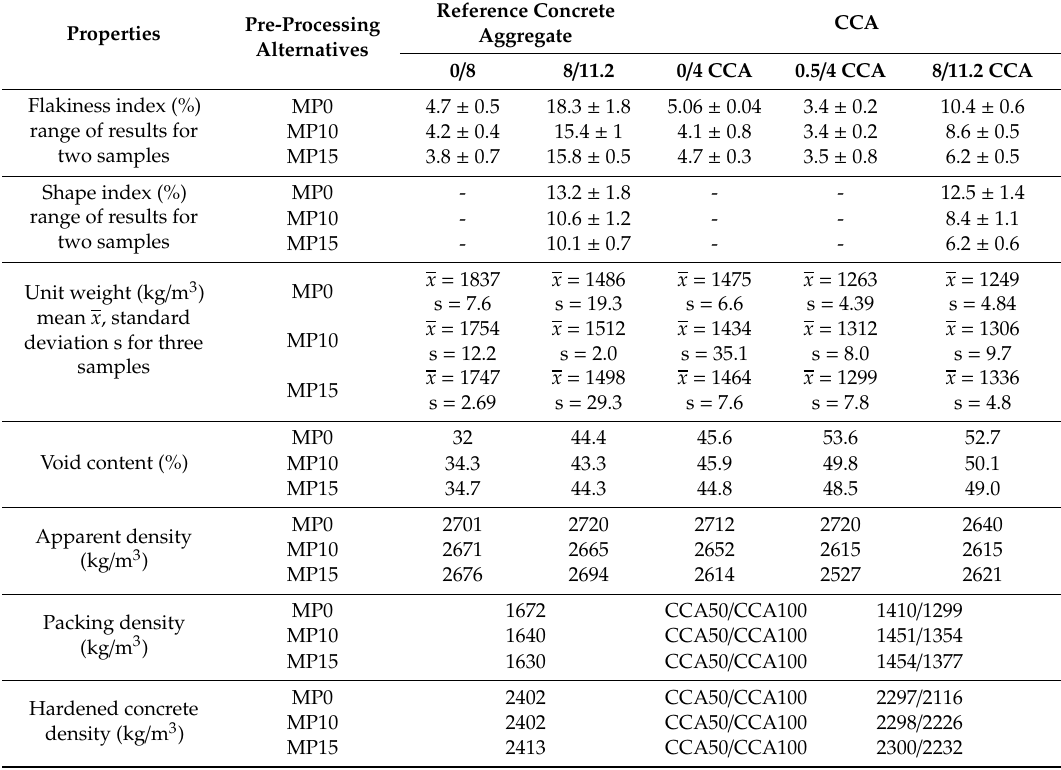
Table 6. Test results of aggregate properties, packing density, and concrete